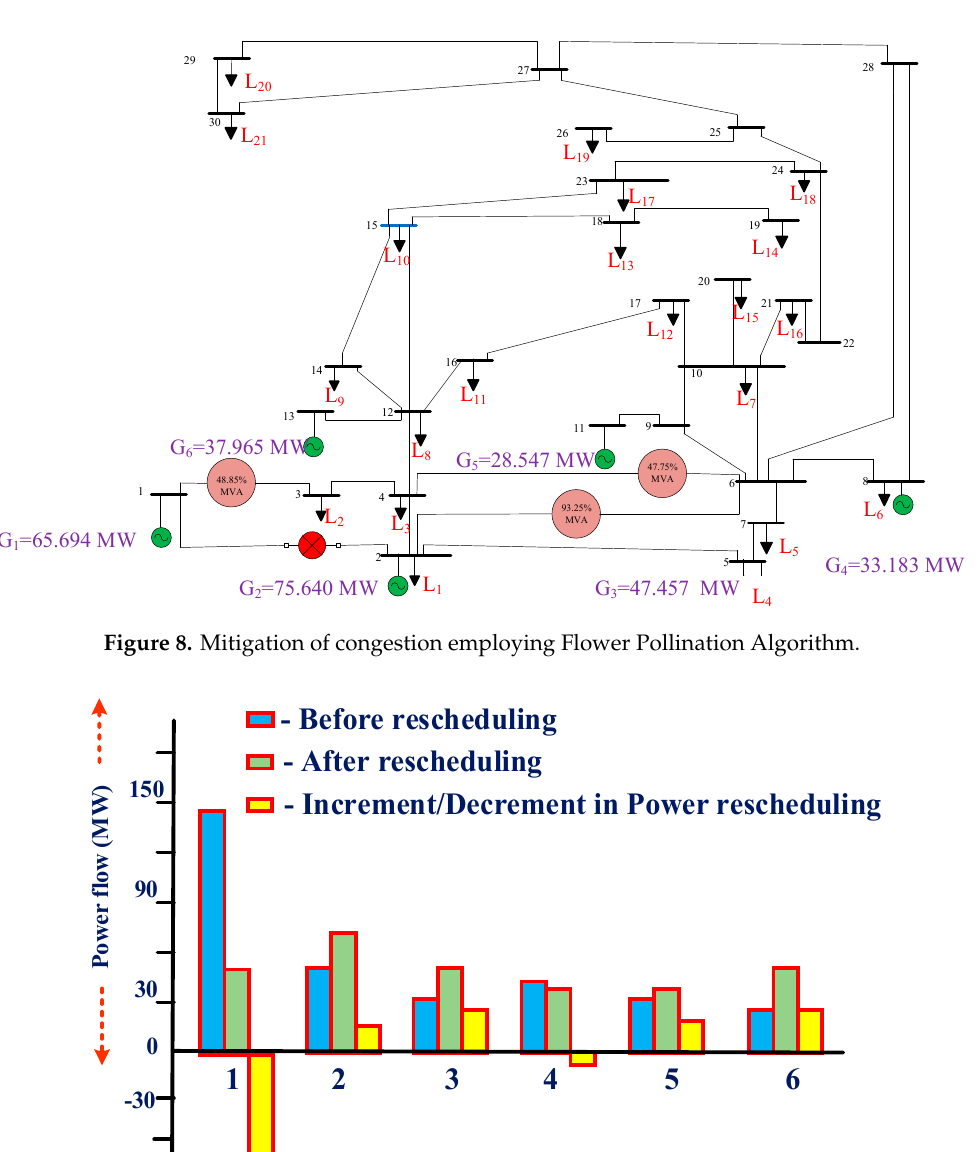
Figure 9. Comparison of power rescheduling in the modified IEEE 30-bus system employing FPA. Table 4. Rescheduling of generators in the modified IEEE 30-bus system.